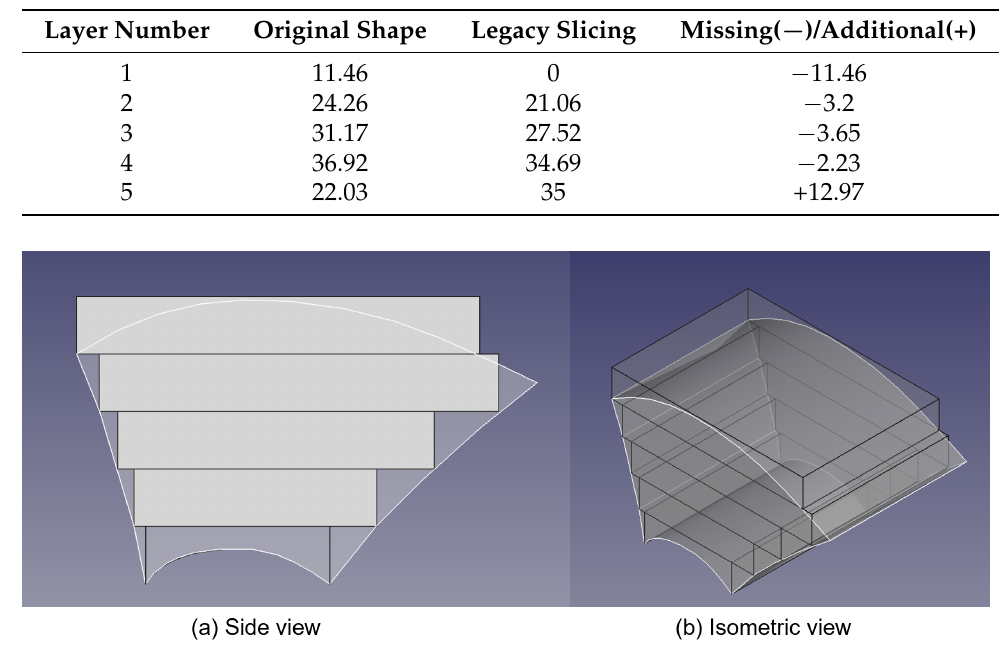
Table 2. Comparison of the volume of each layer.